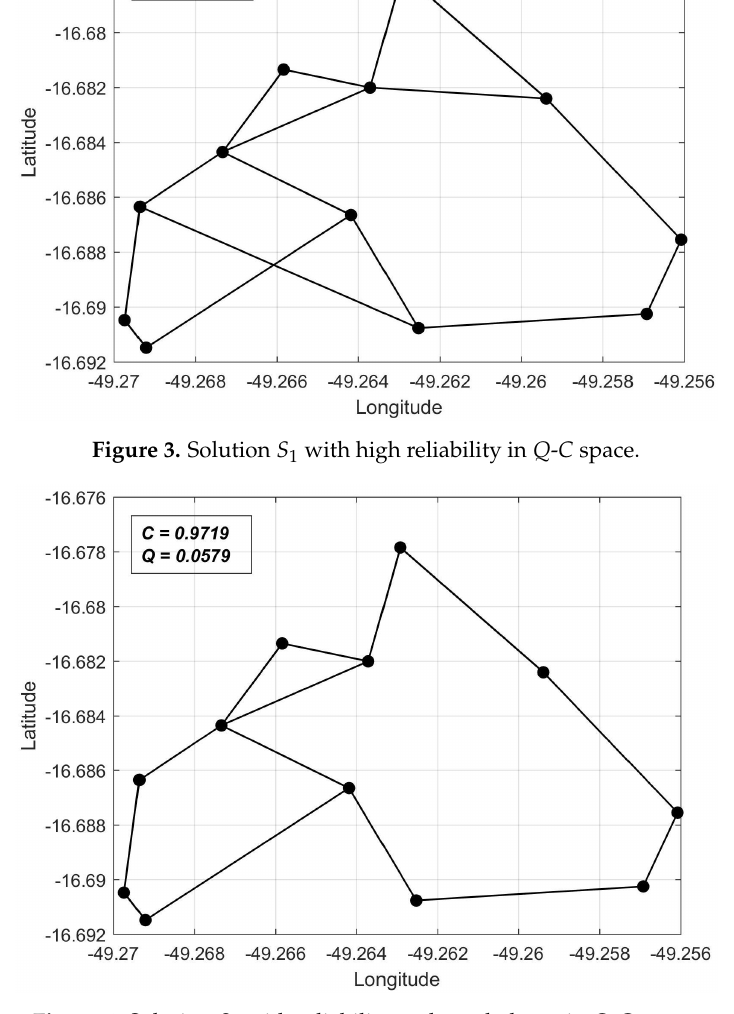
Figure 4. Solution S 2 with reliability and cost balance in Q - C space.